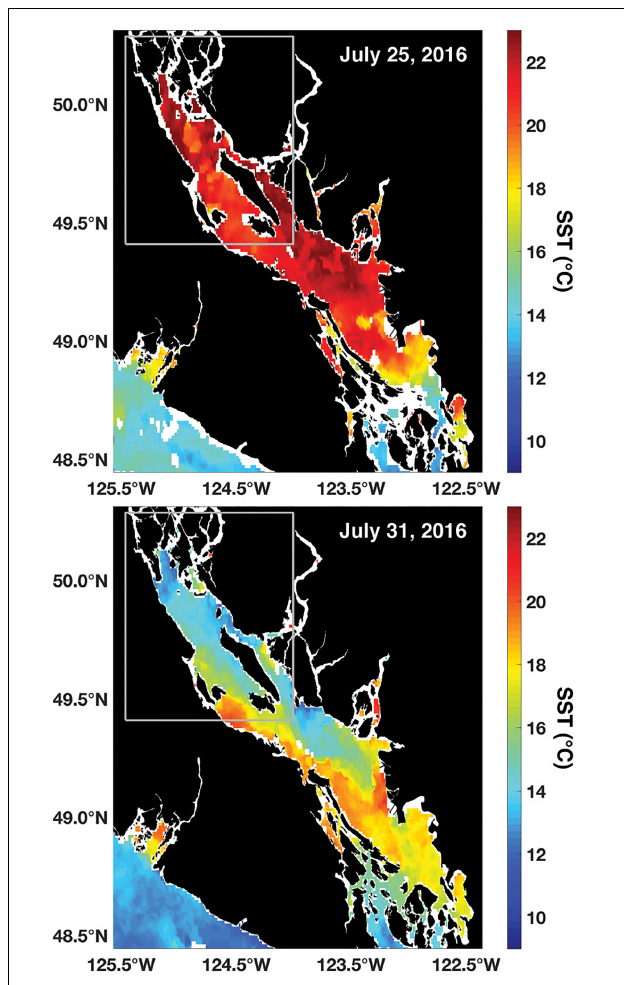
FIGURE 6 | NOAA Polar Operational Environmental Satellite (POES) Advanced Very High Resolution Radiometer (AVHRR) daily average (night and day passes) 1.1 km SST ( ◦ C) at the start (top) and peak (bottom) of the July 2016 high-CO 2 event. The gray box marks the NSS as outlined in Figure 1